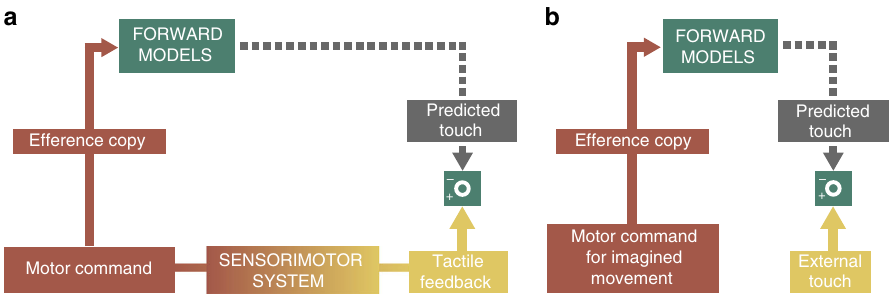
Fig. 4 Computational equivalence between imagined and executed movements. a Somatosensory attenuation associated with pressing one index fi nger against the other. Given a copy of the motor command, the forward models predict the next state of the body and the associated sensory consequences of this state. When pressing one fi nger against the other, these sensory consequences include the tactile feedback from the self-touch. The predicted touch is used to attenuate the actual tactile feedback (comparator). This model is based on an earlier proposal 38 . b Somatosensory attenuation during imagining pressing one index fi nger against the other. For the covert action, the forward models predict tactile feedback based on the efference copy that is generated as part of the internal simulation of the action. When touch is applied externally on the fi nger in a way that matches the predicted feedback from the imagined movement, the somatosensory sensation is attenuated, just as occurs during real self-touch, because the forward models have already predicted